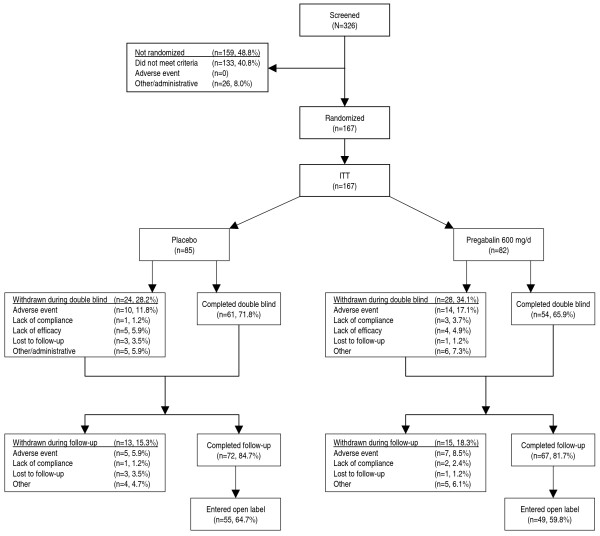
Patient disposition.